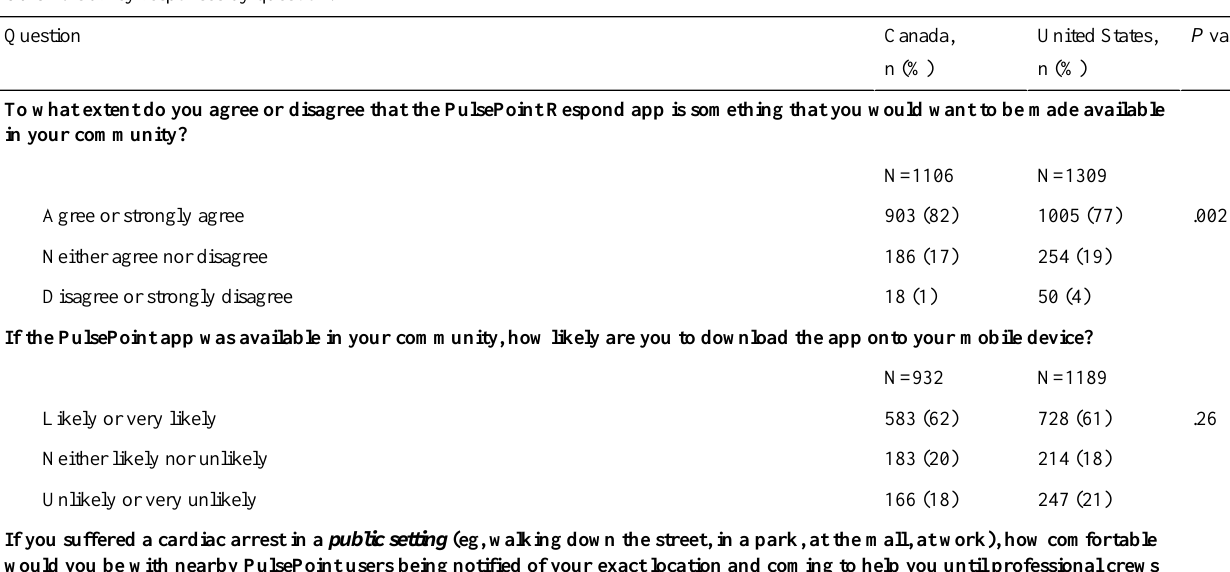
Table 2. Survey responses by question.